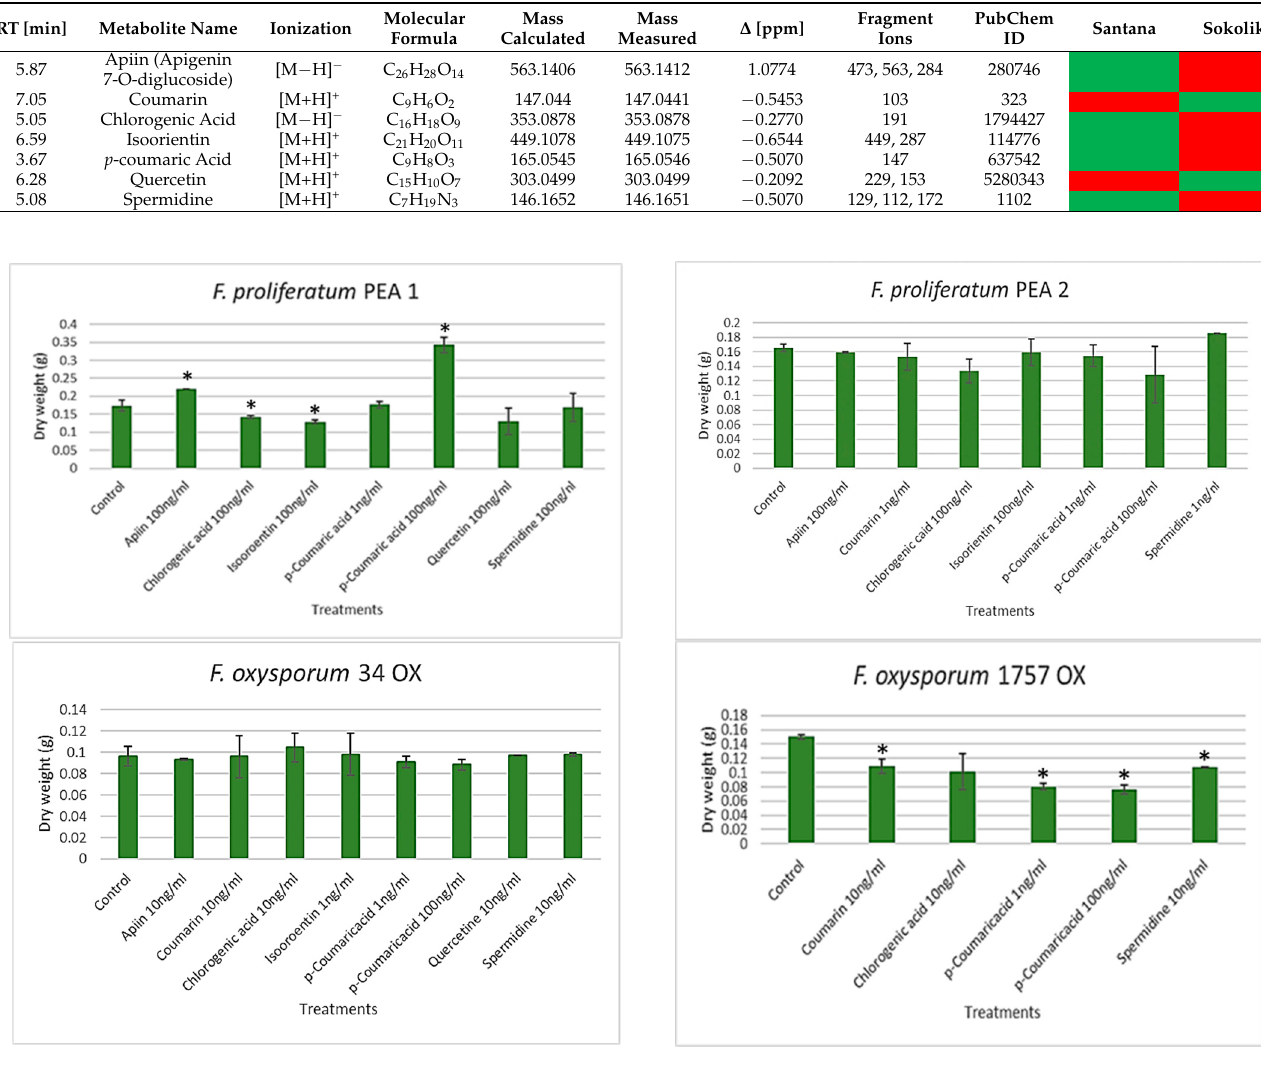
Figure 3. Dry mycelial weight (in grams) of F. proliferatum (PEA1 and PEA2) and F. oxysporum (34 OX and 1757 OX) strains on 14th day of culturing with various metabolites. Error bars represent standard error. * Statistically significant ( p < 0.05).